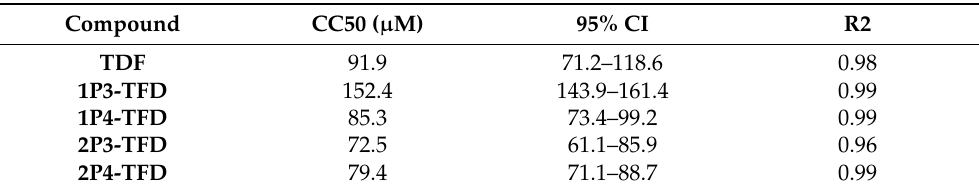
Table 1. Cytotoxicity of tenofovir disoproxil fumarate (TDF) and poly(ethylene glycol) monomethyl ether and poly(ethylene phosphoric acid) (mPEG- b -PEPA) adducts of tenofovir disoproxil (TFD). Compound